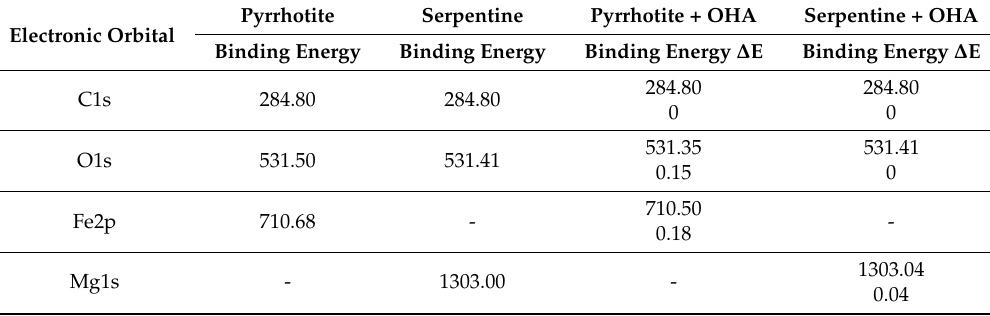
Table 5. The shift energies of valence electrons on the surfaces of pyrrhotite (ET = 24 h) and serpentine, before and after treatment with OHA (Binding Energy/ Δ E: eV).